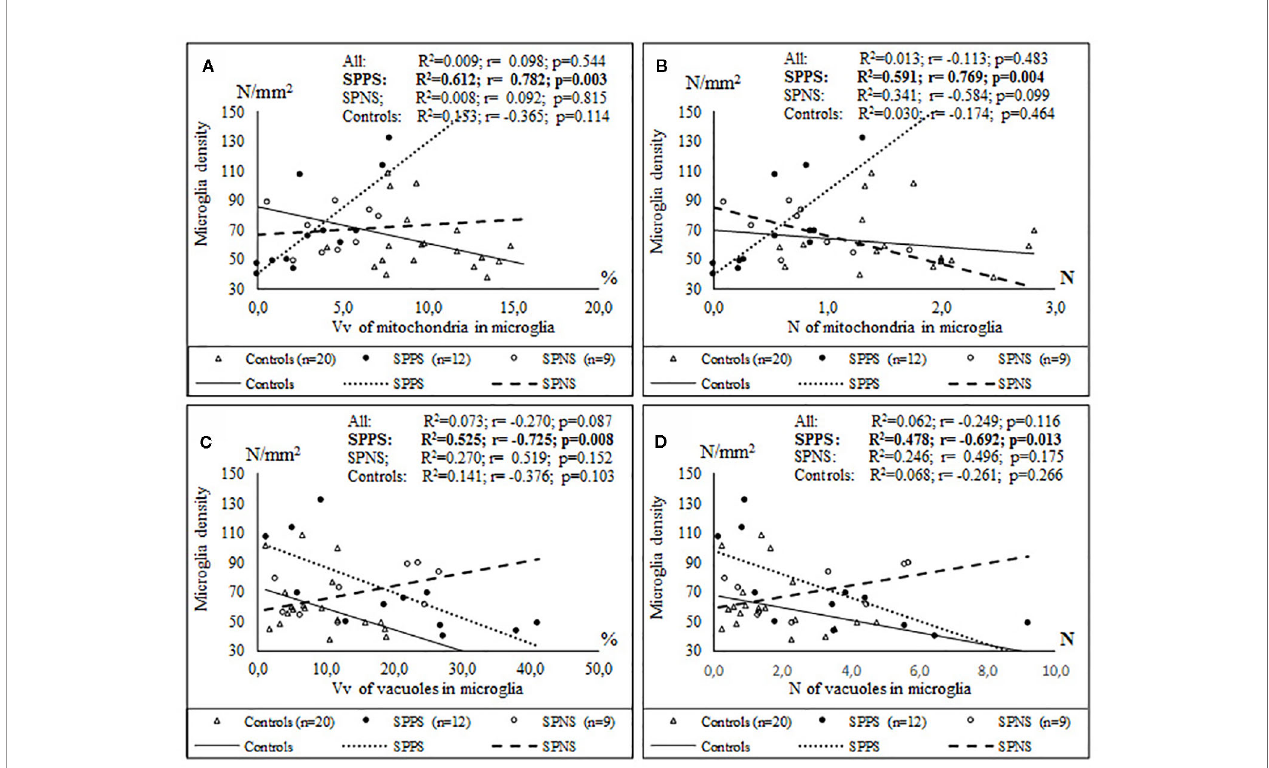
FIGURE 7 | Positive signi fi cant correlations between Vv and N of mitochondria in microglia and microglial density (A, B) and negative signi fi cant correlations between Vv and N of vacuoles in microglia and microglial density (C, D) in the SPPS